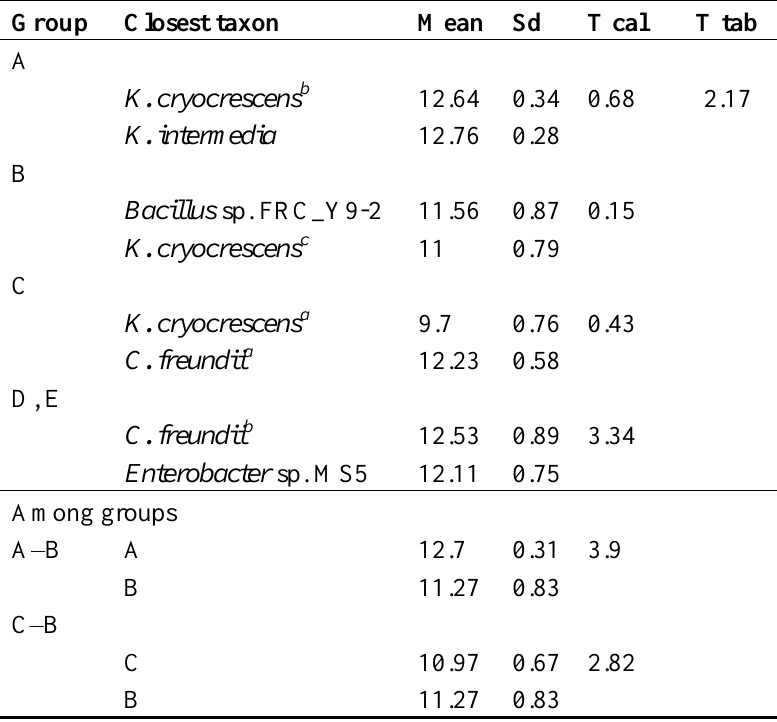
Table 6. Comparison of means using Student’s t